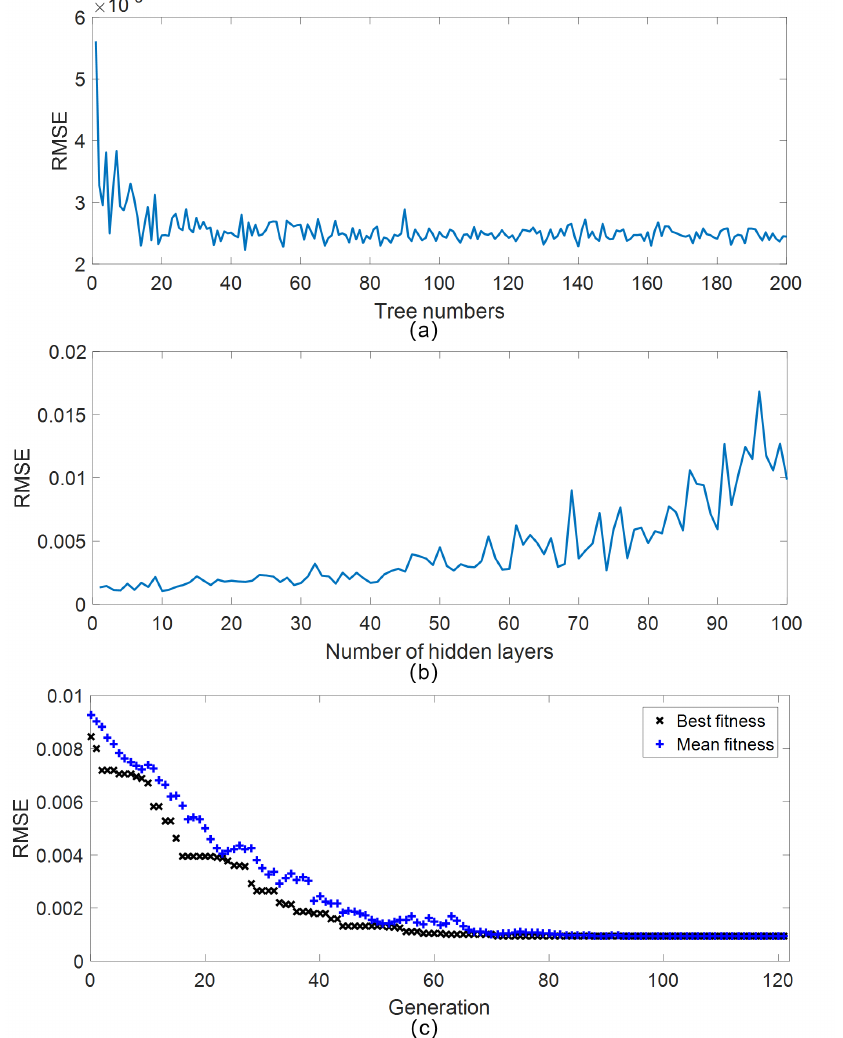
Figure 7. Data-based models parameters optimization: ( a ) RF regression with increasing trees, best root-mean-square error (RMSE) of 0.0022 Nm with 44 trees. ( b ) NN regression with increasing hidden layers, best RMSE of 0.0011 Nm with 10 hidden layers. ( c ) SVM regression with genetic algorithm optimizing parameters, best RMSE of 0.0009 Nm with c (70.716), p (0.019) and g